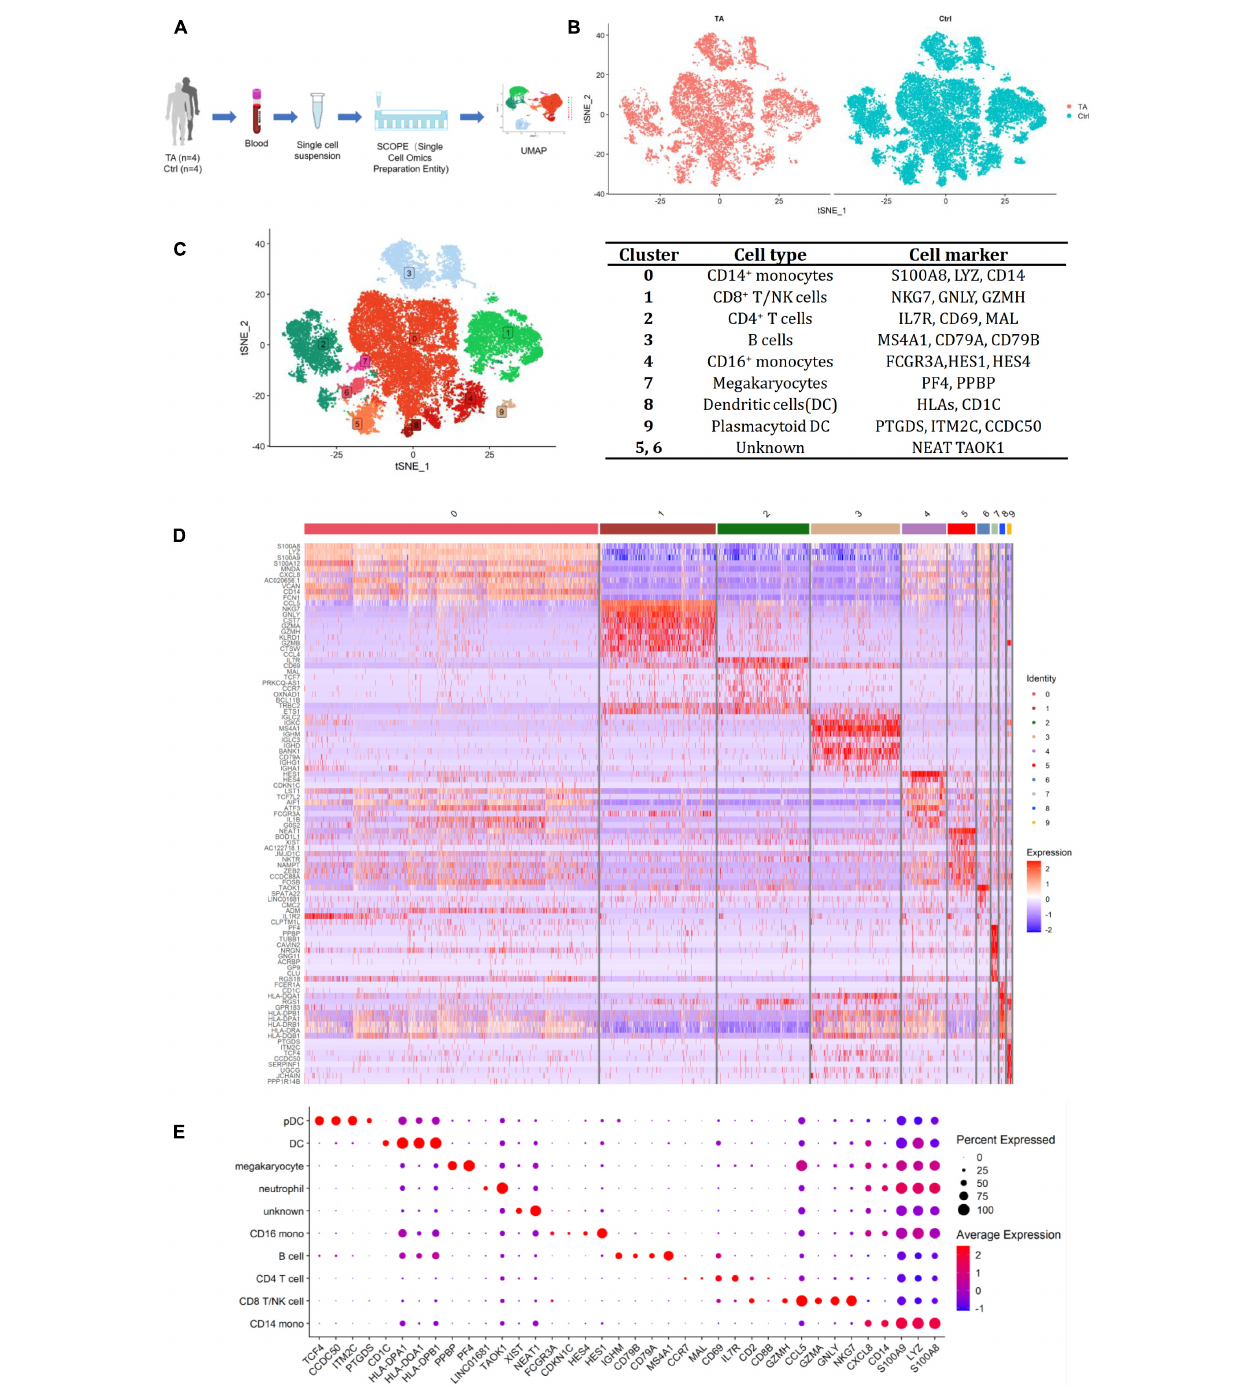
FIGURE 1 | (A) The process of scRNA-seq. (B) Heterogeneity of TA and Ctrl group. (C) tSNE of 4 TA and 4 control samples and representative cell markers for each cluster, all cells were divided into 10 clusters. (D) Heatmap for 10 clusters. (E) Dotplot for 10 clusters. We chose 38 most representative markers for each cell type for dot plot construction. According to different expressed genes (DEGs) in heatmap, feature plots and dot plot, we verified CD14 + monocytes (cluster 0) by S100A8, LYZ, CD14; CD8 + T/NK cells (cluster 1) by NKG7, GNLY, GZMH; CD4 + T cells (cluster 2) by IL7R, CD69, MAL; B cells (cluster 3) by MS4A1, CD79A, CD79B; CD16 + monocytes (cluster 4) by HES1, HES4, FCGR3A; Megakaryocytes (cluster 7) by PF4, PPBP; Dendritic cells (cluster 8) by HLA-DPB1, HLA-DQA1, CD1C; Plasmacytoid dendritic cells (cluster 9) by PTGDS, ITM2C, CCDC50 and Undefined cells (cluster 5, 6) by NEAT1, XIST, TAOK1.